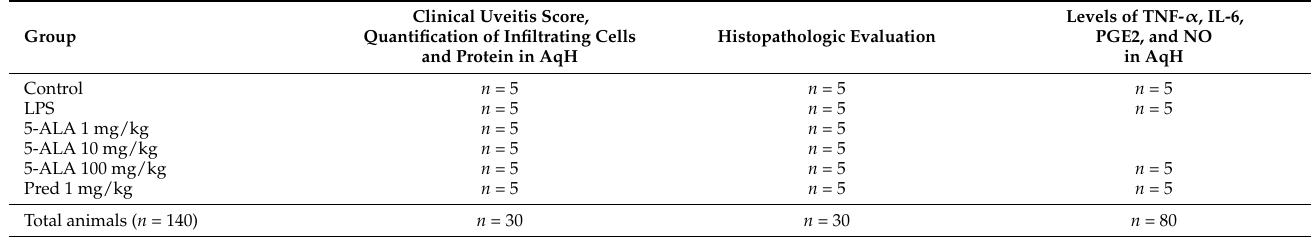
Table 1. Number of animals